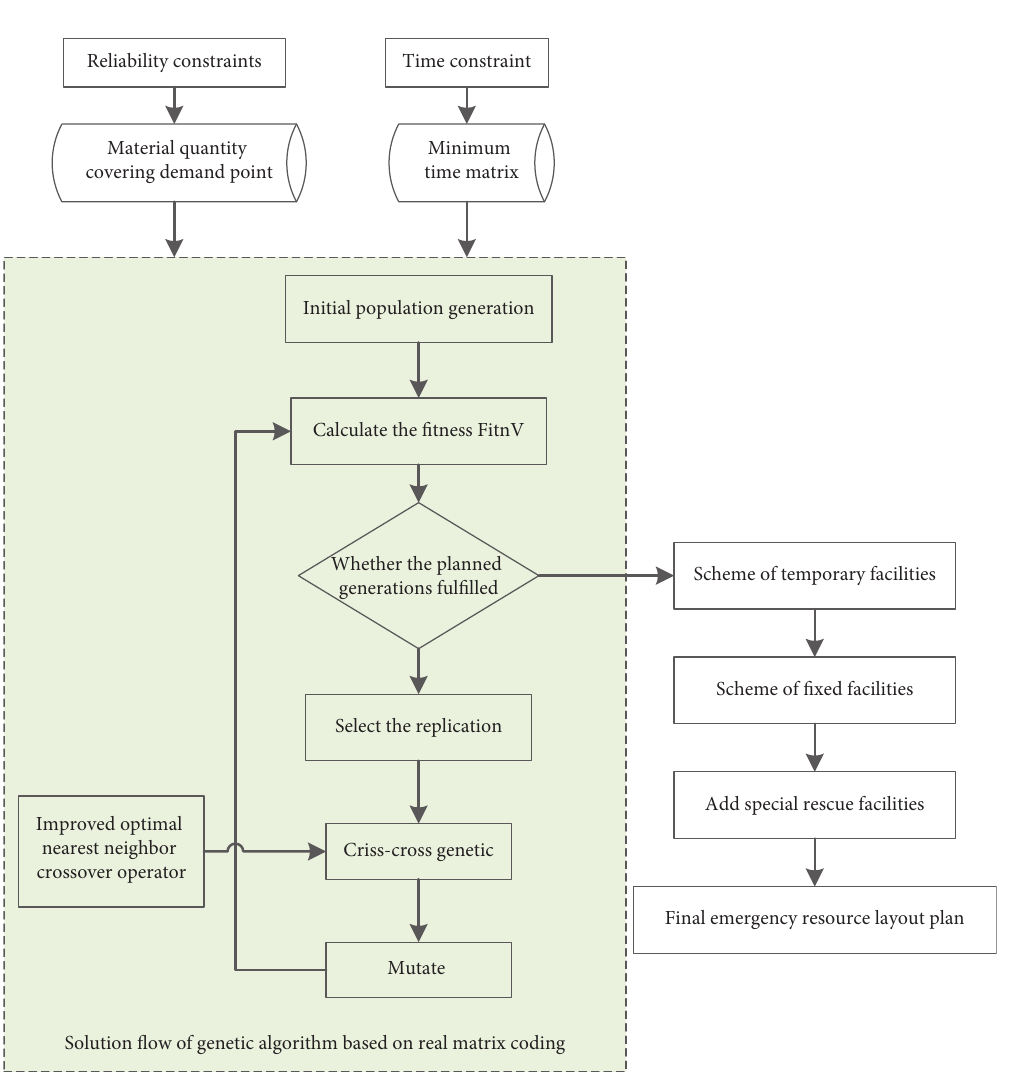
Figure 1: Flowchart of model solving